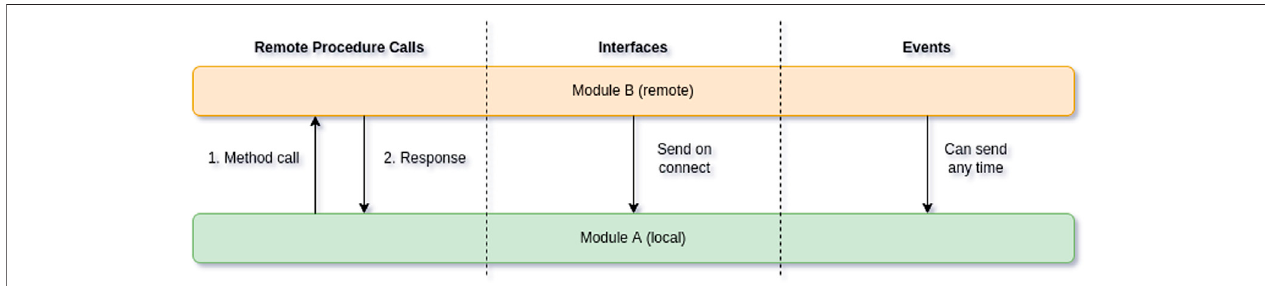
FIGURE1| Thethreepillarsofcommunicationinpyobs,describedasinteractionsbetweenalocalmoduleAandaremotemoduleB.Ontheleft,remoteprocedure calls are actively called on another module. The list of interfaces, in the middle, is automatically retrieved after the connection to the XMPP server has been established. And events can be sent at any time, as shown on the right. Only those events can be handled in a module that it had registered